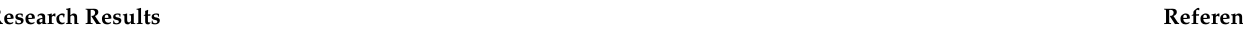
Table 3. The results of studies conducted on sorghum-based flat breads with preferment (injera and